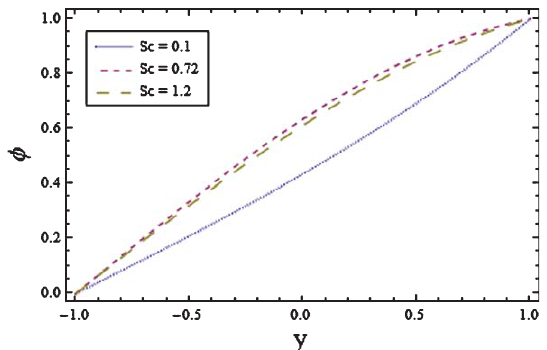
Fig. 17. Plot of heat transfer coefficient Z for various values of the Dufour number Du with (cid:15) = 0 . 1, t = 0 . 1 , Sc = 1 , Sr = 2 , γ = 1 , γ = 10 , Pr = 1 . 5 and γ = 1 2